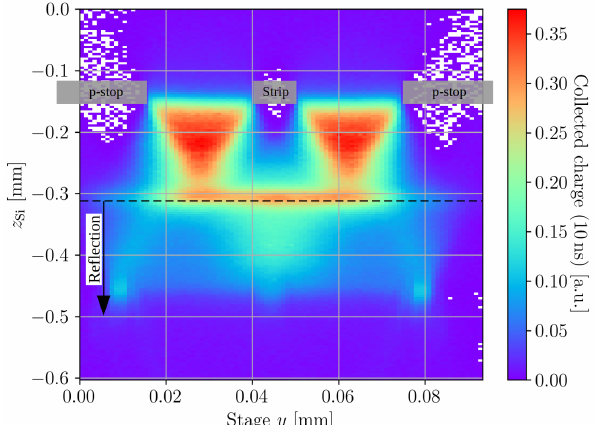
Figure 4. Charge collected within 10ns for a yz -scan, taken at a bias voltage of 100V. The scan is performed between the middle of the p-stop left of the readout strip ( y = 0mm) and the middle of the right p-stop ( y = 0.9mm). The top side metallisation is located at z top = − 0.154mm and the backside metallisation is indicated by the black dashed line at about z back = − 0.31mm. All the signals acquired behind the back side metallisation are attributed to a focused reflection at the back side metal. The readout strip’s metal and the metals above the p-stop are shown schematically by the transparent grey